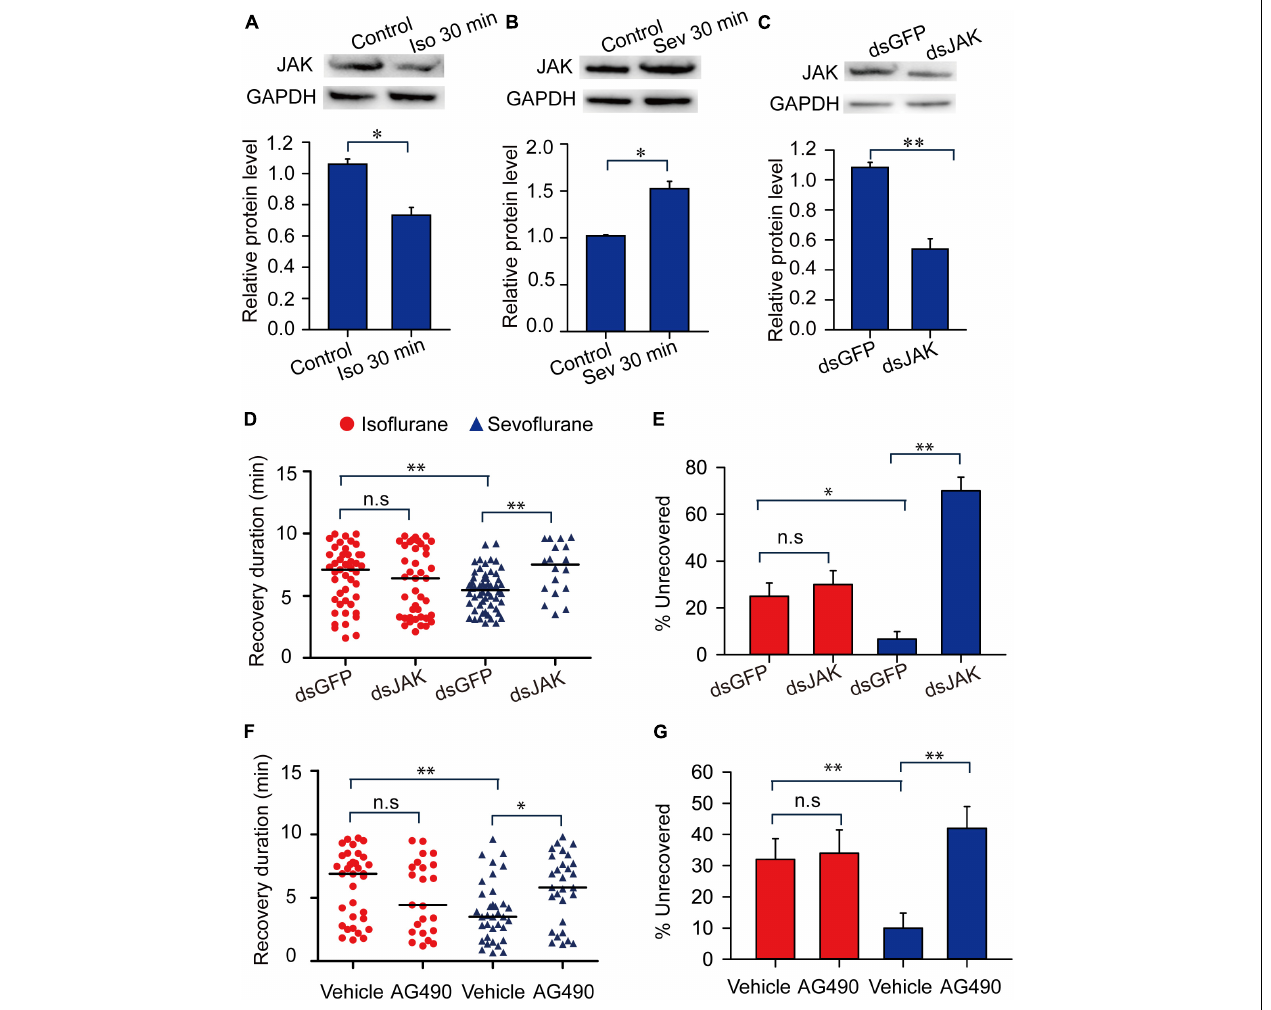
FIGURE 8 | Janus kinase mediates the shorter duration of recovery duration from sevoflurane anesthesia than isoflurane anesthesia. (A) Isoflurane anesthesia induces the decrease of the expression level of JAK protein ( n = 6). (B) Sevoflurane anesthesia induces the increase of the expression level of JAK protein ( n = 6). (C) JAK RNAi knockdown results in the decrease of JAK protein levels in brains of the migratory locusts ( n = 6). (D,E) JAK RNAi knockdown (D) results in longer duration of recovery from sevoflurane anesthesia, and increases the percentage of unrecovered locusts with sevoflurane anesthesia (E) within 10 min after discontinuing anesthesia ( n = 40 for each treatment). (F,G) Injection of JAK inhibitor AG490 (F) results in the longer duration of recovery from sevoflurane anesthesia, and increases the percentage of unrecovered locusts with sevoflurane anesthesia (G) within 10 min after discontinuing anesthesia ( n = 40 for each treatment). Student’s t -test is performed to analyze statistical significance of JAK expression levels compared with the corresponding controls. Mann–Whitney U test is used for analyzing differential recovery duration from isoflurane and sevoflurane anesthesia, and G-test for independence is used for analyzing the effects of JAK deficiency on the percentage of unrecovered locusts within 10 min after discontinuing anesthesia. n.s P > 0.05, ∗∗ P < 0.01, ∗ P < 0.05. JAK, Janus kinase, ISO, isoflurane, SEV, sevoflurane, STAT5B, signal transducer and activator of transcription